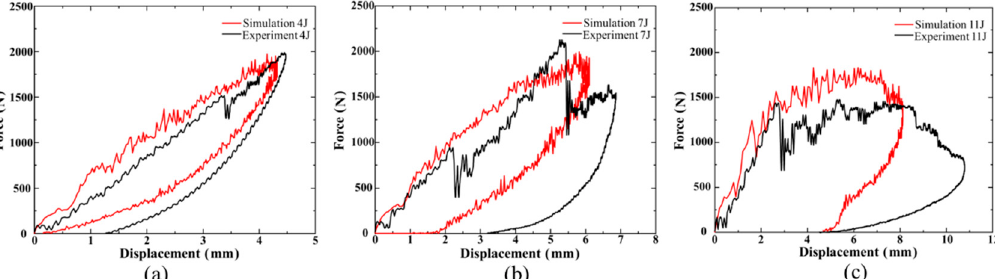
Figure 7. Comparison of numerical and experimental force–displacement curve of UACS laminates under impacts ( a ) 4 J, ( b ) 7 J and ( c ) 11 J.